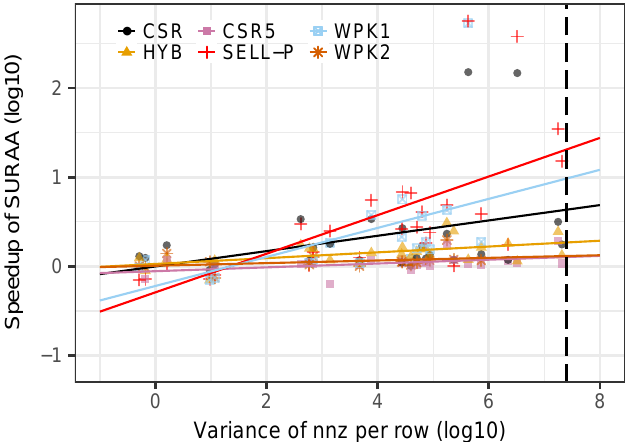
Figure 11. SURAA speedup against npr variance for the 26 benchmark matrices (compared for CSR5, WPK1, WPK2, HYB, SELL-P, and